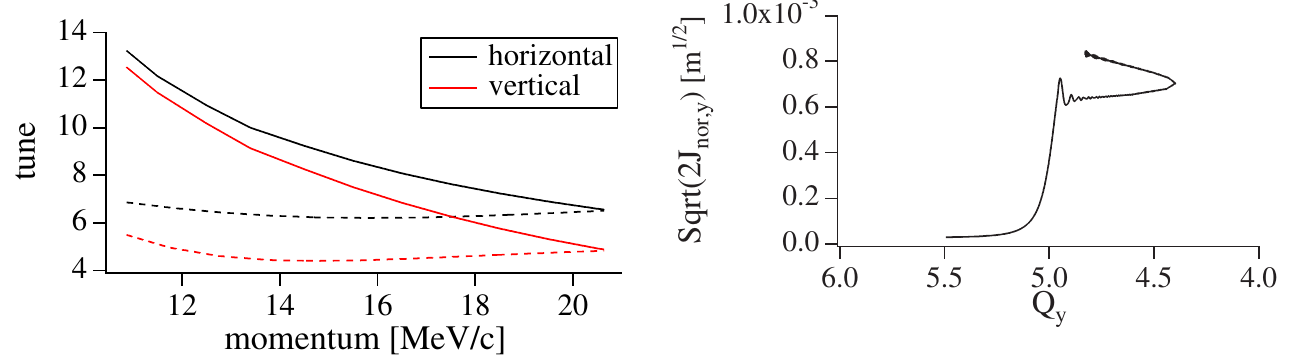
FIG. 6. (Color) Dashed lines show horizontal and vertical total tunes as a function of momentum when sextupole and octupole are introduced to correct the chromaticity. Solid lines are the same as Fig. 1.